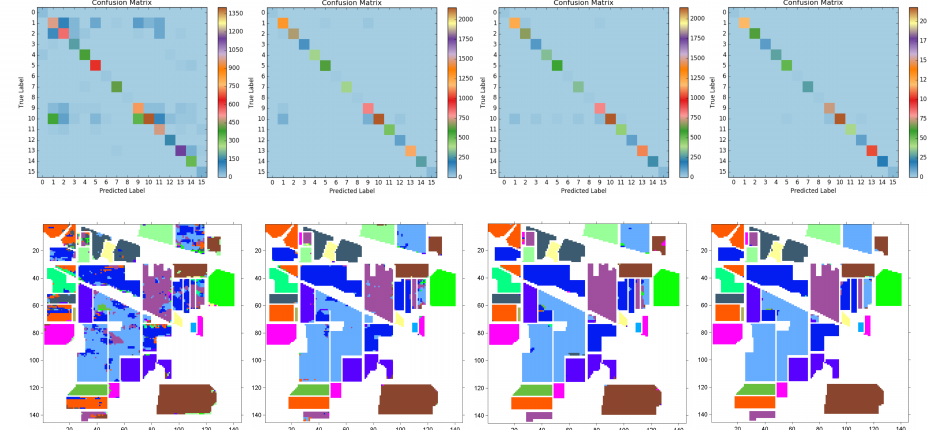
Figure 11. Classification results for the IP image with d = 9 and number of samples per category = 50 (first column), 100 (second column), 150 (third column), and 200 (fourth column). The upper row represents the visualization results of the confusion matrix for each category on the testing set (the more prominent the color of the diagonal area, the better the result) and the lower row represents the qualitative results of classification